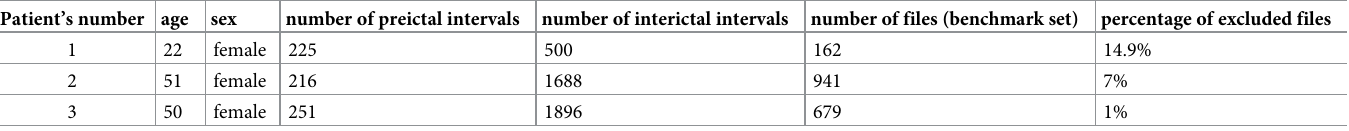
Table 2. Detailed information about the Epilesyecosystem dataset (after excluding corrupted files). [22] The number of preictal intervals is the same as the number of seizures in the public dataset, while for files in the benchmark dataset labels are not publicly known. Patient’s number age